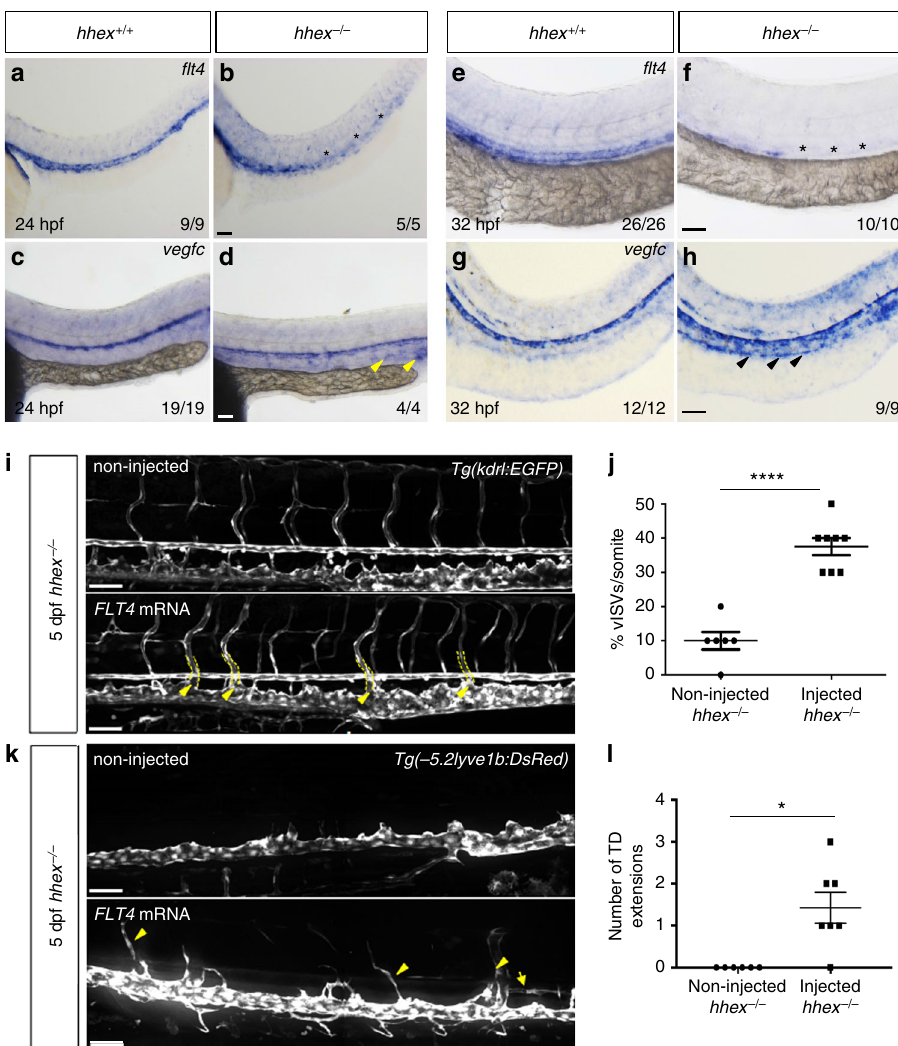
Fig. 2 The Vegfc/Flt4 pathway is affected in zebra fi sh hhex mutants. a – d Whole-mount in situ hybridization showing fl t4 ( a , b ) and vegfc ( c , d ) expression in 24 hpf hhex + / + and hhex − / − embryos. At 24 hpf, hhex mutants exhibit decreased fl t4 expression (asterisks), whereas vegfc expression in the PCV appears to be slightly increased (arrowheads). e – h Whole-mount in situ hybridization showing fl t4 ( e , f ) and vegfc ( g , h ) expression at 32 hpf in hhex + / + and hhex − / − embryos. At 32 hpf, hhex mutants exhibit a strong decrease in fl t4 expression (asterisks), whereas vegfc expression is clearly increased in the PCV (arrowheads). x / y : number of embryos showing representative phenotype ( x ), number of embryos examined ( y ). i Trunk vasculature of 5 dpf Tg(kdrl:EGFP); hhex − / − injected, or not, with full-length human FLT4 mRNA. hhex mutants exhibit partial rescue of their vISVs at 5 dpf (arrowheads point to vISVs). j Quanti fi cation of vISVs across 10 somites in 5 dpf non-injected hhex − / − ( n = 6) and FLT4 mRNA-injected hhex − / − ( n = 8). k Trunk lymphatic vasculature of 5 dpf Tg( − 5.2lyve1b:DsRed); hhex − / − injected, or not, with full-length human FLT4 mRNA. hhex mutants exhibit partial rescue of their TD at 5 dpf (arrowheads point to vISVs and arrow points to TD). l Quanti fi cation of TD extensions across 10 somites in 5 dpf non-injected hhex − / − ( n = 6) and FLT4 mRNA-injected hhex − / − ( n = 7). Values represent means ± s.e.m. **** P ≤ 0.0001 and * P ≤ 0.05 by t -test. Scale bars: 50 μ